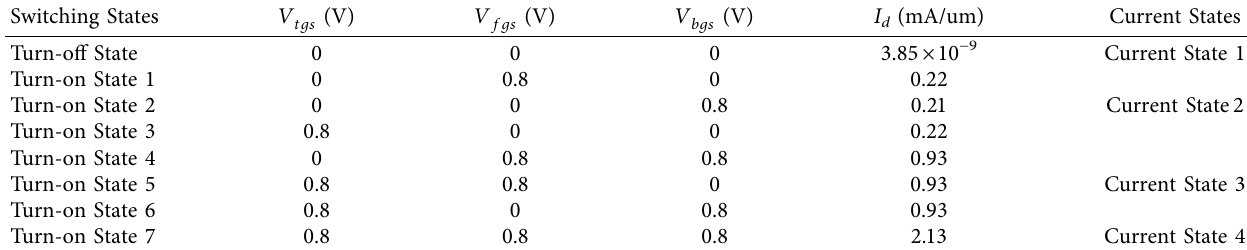
Figure 12: Drain current of the PSF-TiFET with different V Table 2: The turn-on current and turn-off currents of the N-type